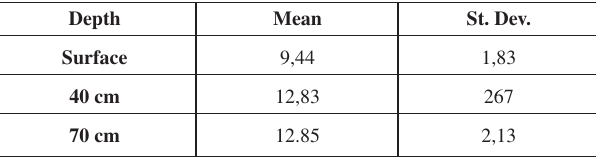
Table 3. Actual water content (V%) in the three soil layers Depth Mean St.